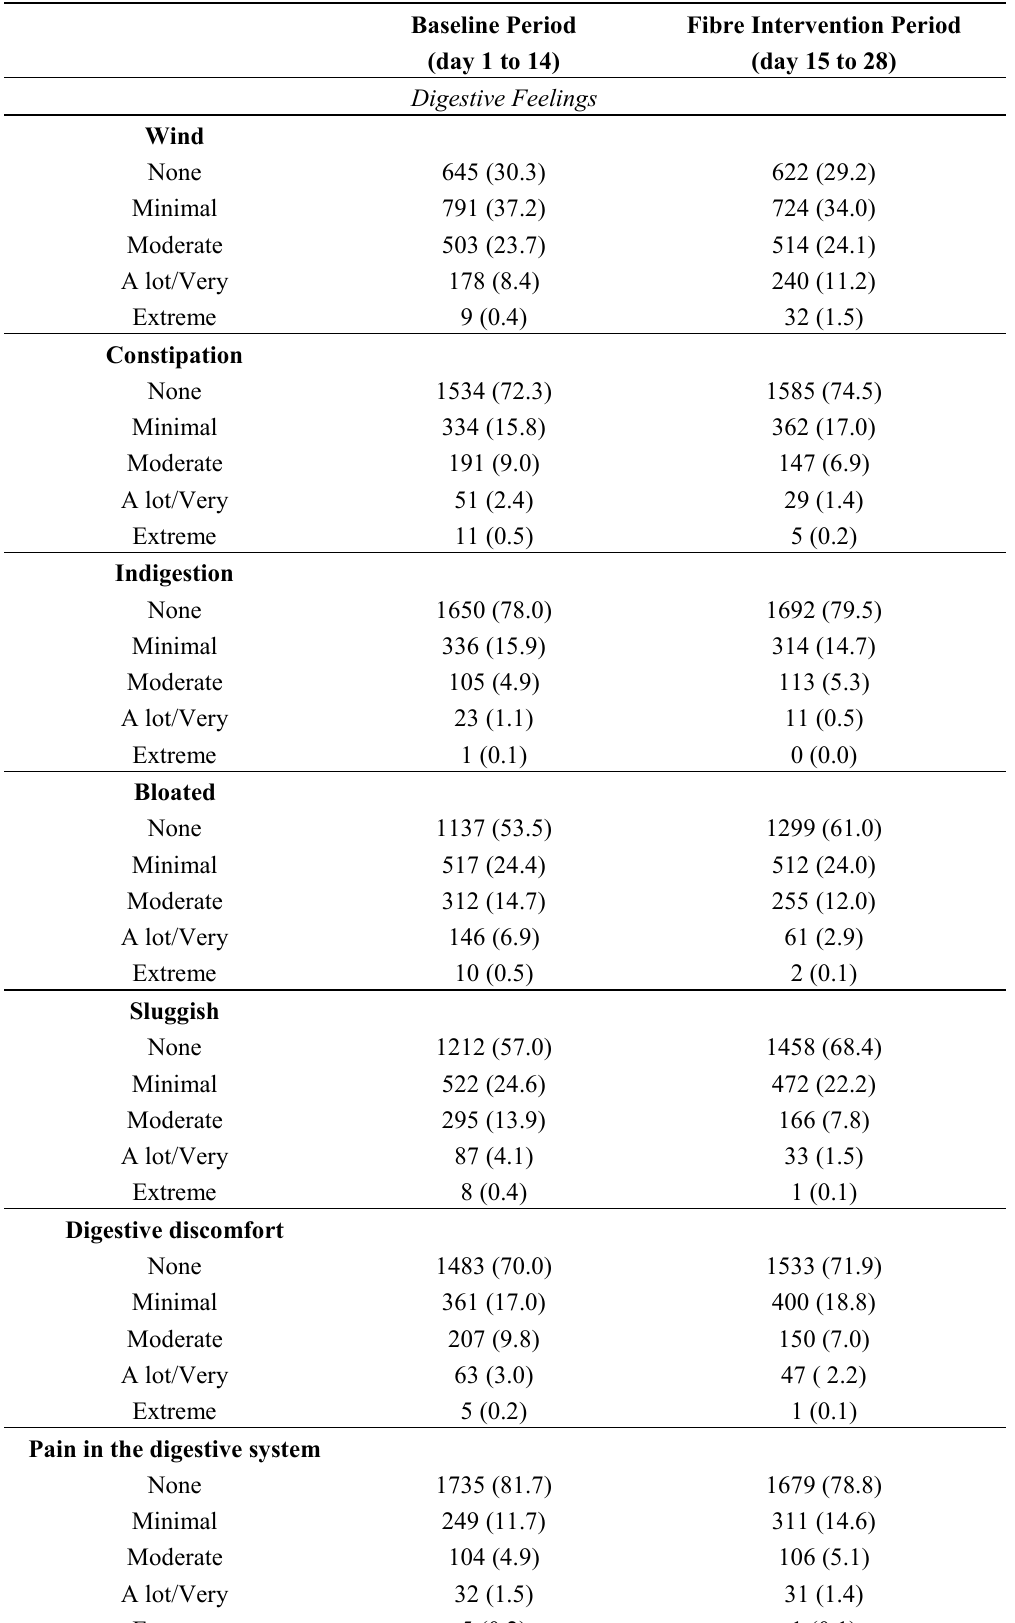
Table 3. Digestive feelings, Bowel Function and General Wellbeing: Frequency 1 (percent) of days of reporting of each level of the Likert scale scores across each 14 day period (153